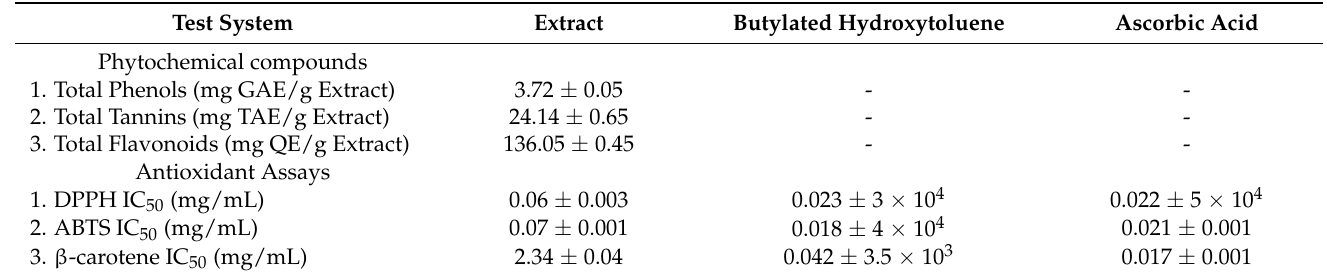
Table 4. Antioxidant activities of Fagonia indica methanol extract (80% v / v ) as compared to known